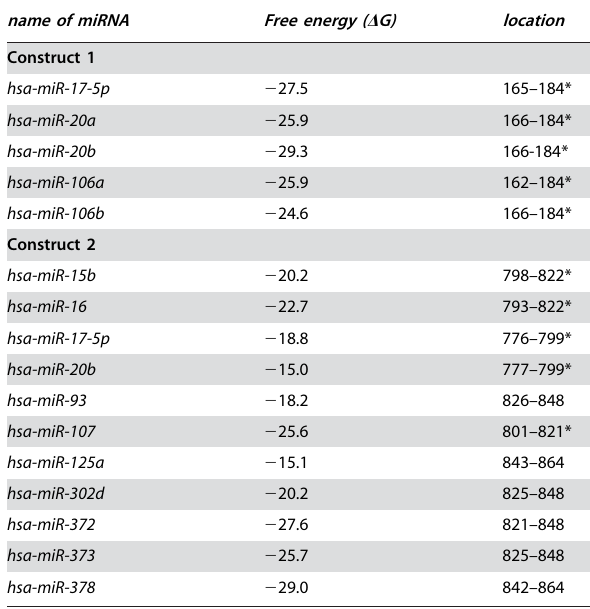
Table 4. miRNA binding sites at fragments of the VEGF 3 9